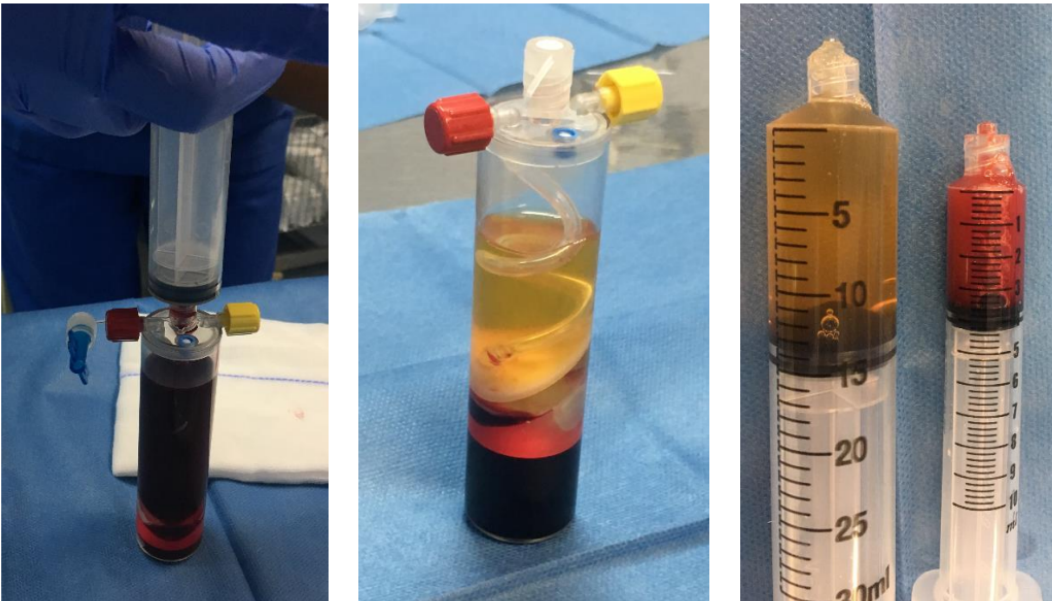
Figure 3. Platelet-rich plasma (PRP) kit-30 mL blood extraction. Platelet poor plasma ( left ), platelets and white blood cells (Buffy Coat) ( center ), red blood cells ( right ).